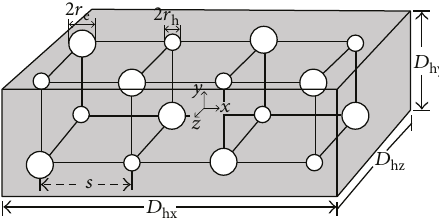
Figure 1: The global lattice composed of two bisphere overlapping lattices of the dielectric particles with di ff erent radius sizes embedded inside the dielectric host (Lattice